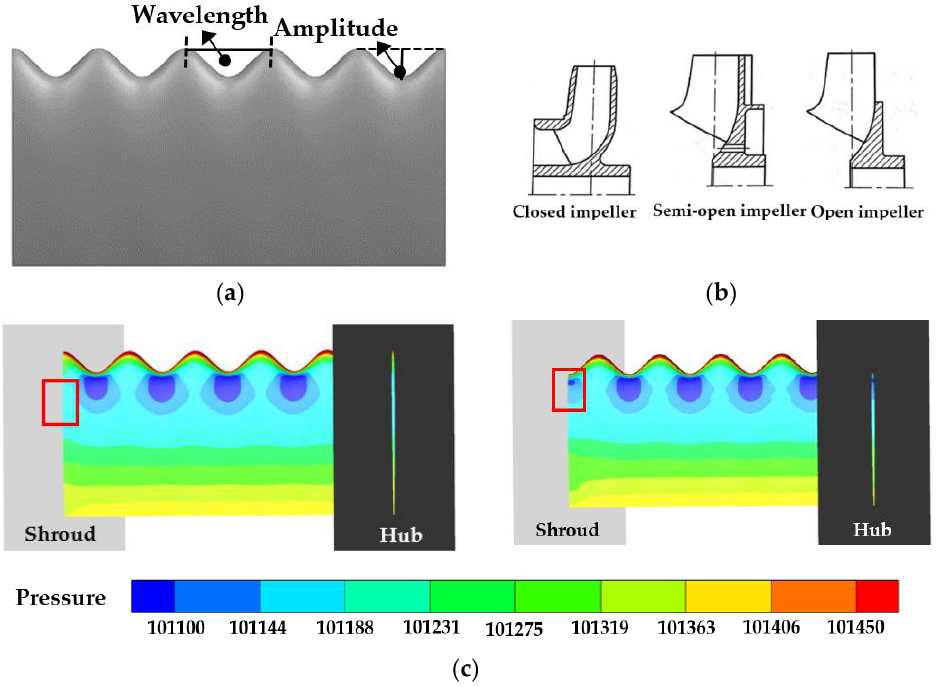
Figure 1. Related pictures in introduction. ( a ) Wave structure; ( b ) Impeller form; ( c ) Pressure distri- bution.